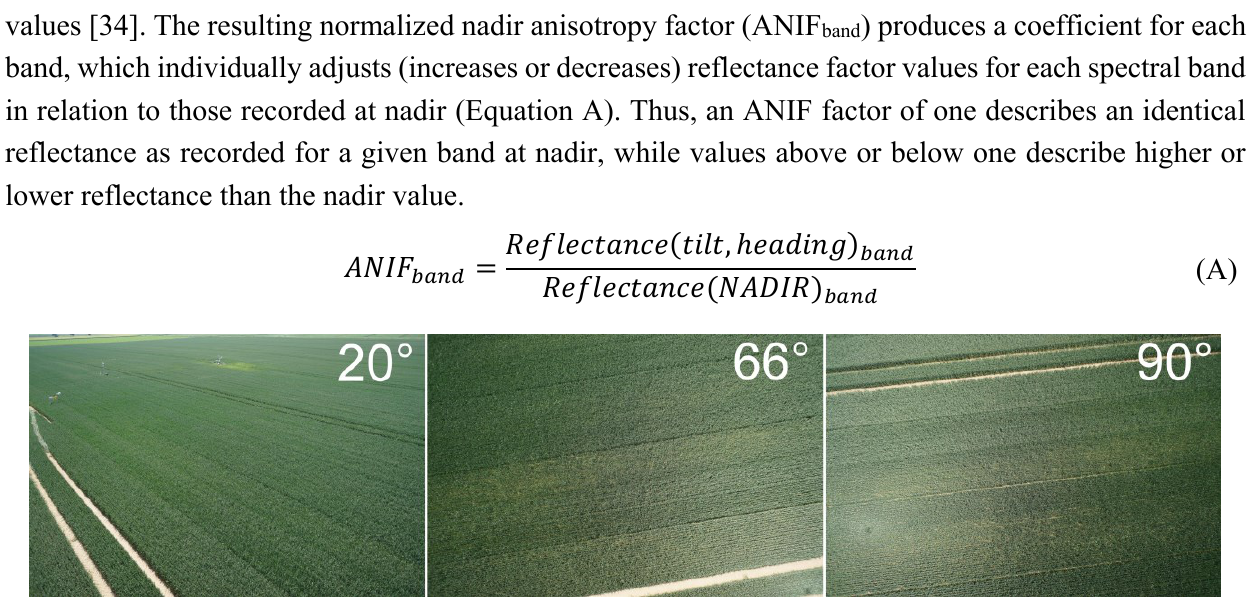
Figure 3. Example Red-Green-Blue (RGB) images with tilt angles of 20°, 66° and 90°.